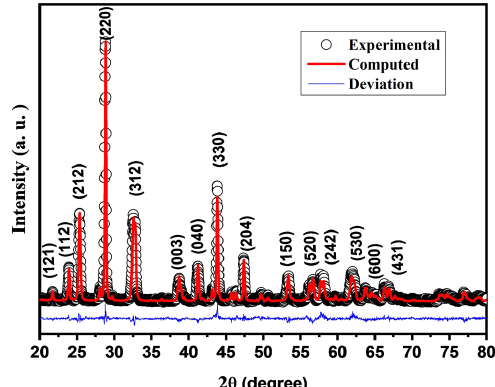
powder calcined 4